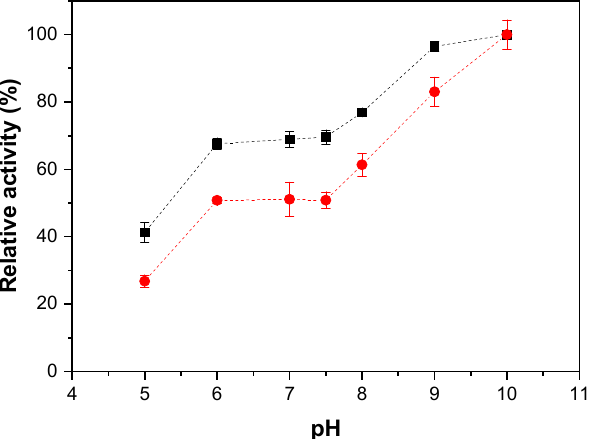
Figure 5. E ff ect of the pH on the activities of ( (cid:4) ) liquid Eversa and ( • ) Eversa-mCLEA. The activity was determined by tributyrin hydrolysis (soluble enzyme concentration of 5 mg / mL or 10 mg of Eversa-mCLEA, pH 7.0, 100 mM sodium phosphate buffer).